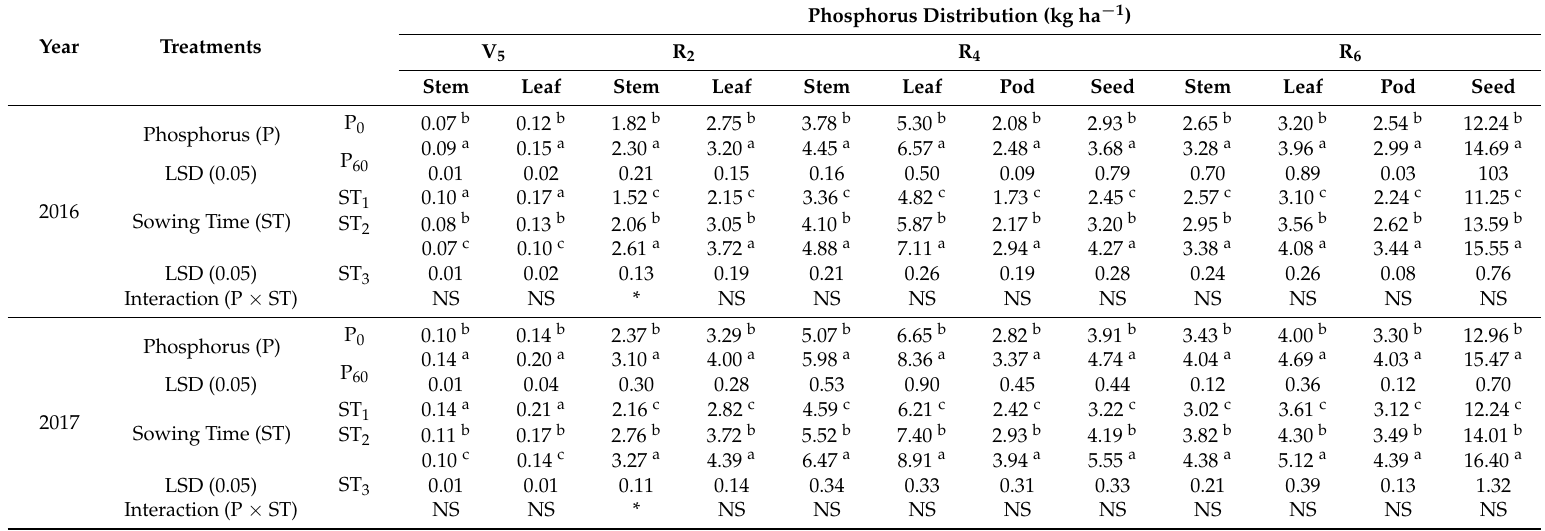
Table 5. Effect of sowing times and phosphorus fertilizer rates on phosphorus distribution of soybean at four stages of phenological development in relay intercropping system with maize during the cropping seasons of 2016 and